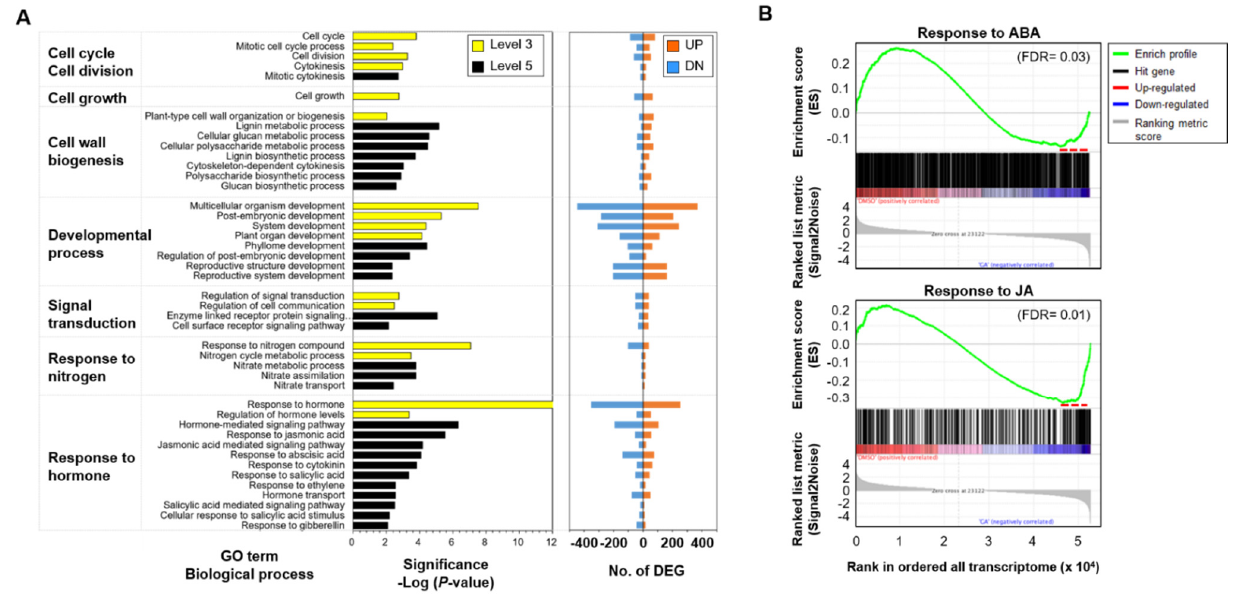
Figure 4. Transcriptome profiling of P. ginseng roots treated with or without GA. ( A ) Gene ontology (GO) enrichment analysis of differentially expressed genes (DEGs) identified by comparison of GA- and DMSO-treated root samples. GO terms of level 3 (yellow bars) and level 5 (black bars), with EASE score < 0.01, were selected (left panel). The number of up-regulated genes (red) and down-regulated genes (blue) categorized under the enriched GO terms are shown in the right panel. ( B ) Enrichment plot for the responses to ABA (GO: 0009737) and JA (GO: 0009753) in the transcriptome data of DMSO- and GA-treated root samples. In the enrichment plot, the red dotted line represents the gene subset that made the largest contribution to the enrichment score (ES) (false discovery rate [FDR] < 0.05). The ranking list metric in the plot measures the correlation between a gene and the plant phenotype. In the ranking list, positive values indicate genes up-regulated in DMSO-treated root samples with red color gradient, and negative values indicate genes down-regulated in DMSO-treated root samples.